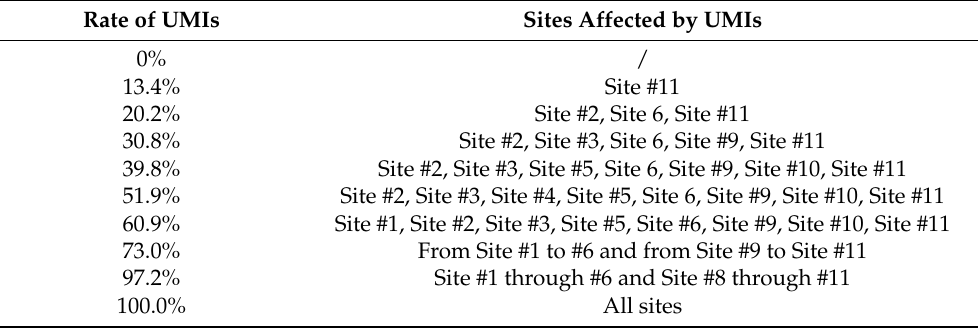
Table 3. Scheme of the sensitivity analysis.